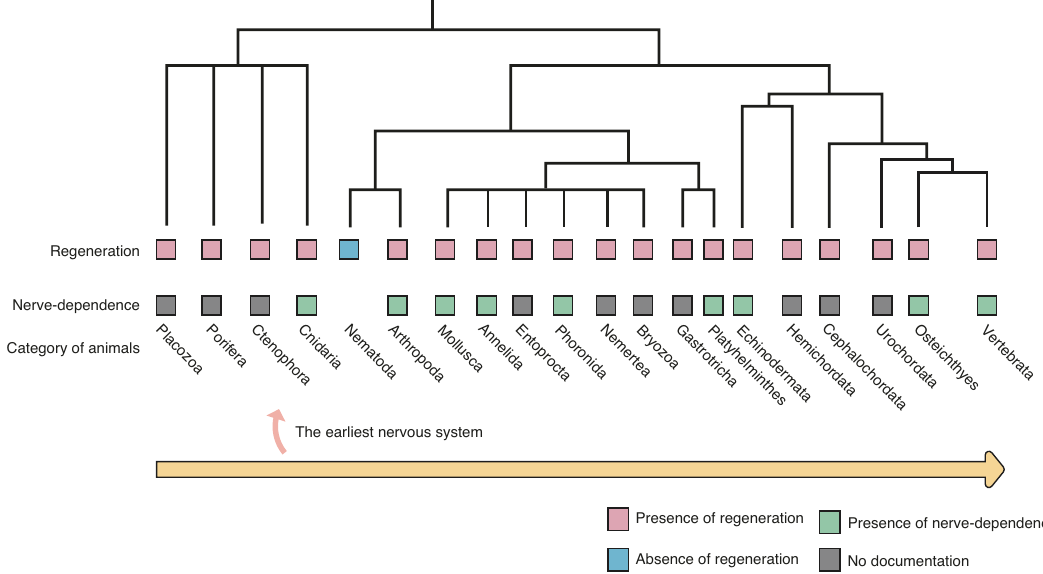
Fig. 1 Distribution of regeneration and its nerve dependence in animals from lower to higher species. This phylogenetic tree topology contains almost all animal species. The yellow arrow at the bottom from left to right indicates the gradient from animals that emerged earlier in evolutionary history (lower organisms) to those that evolved later (higher organisms). The distribution of regeneration capacity in most animal phyla could be con fi rmed in at least one member. “ Presence of regeneration ” means that there is at least one veri fi ed taxon in the corresponding phylum that has the ability to regenerate complex parts of the body; it does not refer to all the taxa included. “ Presence of nerve dependence ” means that there is at least one well-substantiated report indicating the function of the nervous system in regeneration. “ No documentation ” means that more reliable studies are needed on the topic. Tree topologies and regeneration data are based on ref. 292 Data on nerve dependence are based on refs. 21,22,41 – 45,293 –